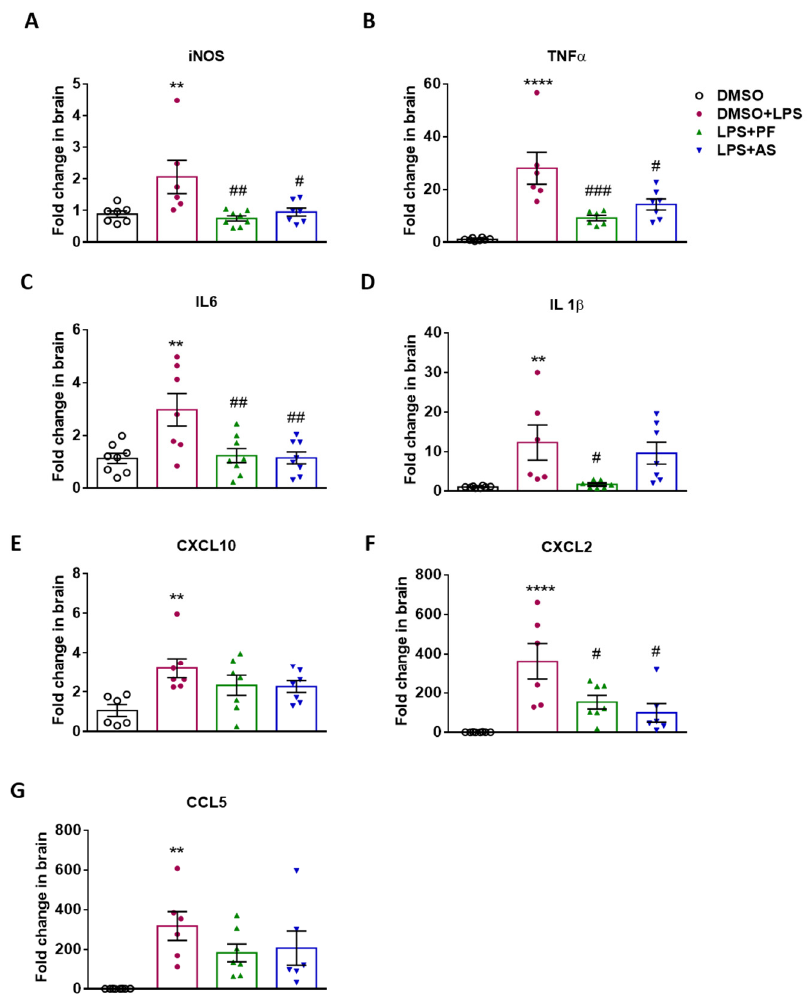
Figure 8. Inhibition of ATX and LPA5 regulates expression of pro-inflammatory genes in LPS-injected C57Bl/6 mice. Mice (n = 6–8 per group) were injected intraperitoneally (i.p.) with DMSO, LPS (5 mg/kg) plus DMSO, with or without PF8380 (‘PF’; 30 mg/kg) or AS2717638 (‘AS’; 10 mg/kg). After 24 h, the animals were sacrificed and the brains were perfused. The right hemisphere from each mouse was processed for RNA isolation and gene expression of ( A ) iNOS, ( B ) TNF α , ( C ) IL6, ( D ) IL-1 β , ( E ) CXCL10, ( F ) CXCL2, and ( G ) CCL5 was evaluated by qPCR. Hypoxanthine-guanine phosphoribosyltransferase (HPRT) was used as housekeeping gene. Expression was calculated using the 2 − ddCt method. Results are presented as mean values ± SEM of 6–8 mice per group (** p < 0.01, **** p < 0.0001 compared to DMSO control; # p < 0.05, ## p < 0.01, ### p < 0.001 compared to LPS-treated mice; one-way ANOVA with Bonferroni correction).